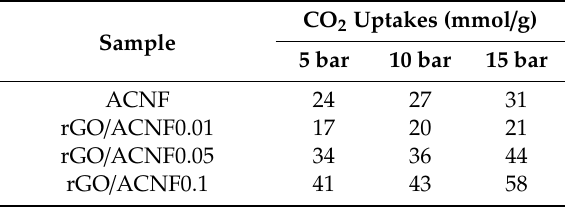
Table 2. CO 2 uptakes at di ff erent pressures at ambient